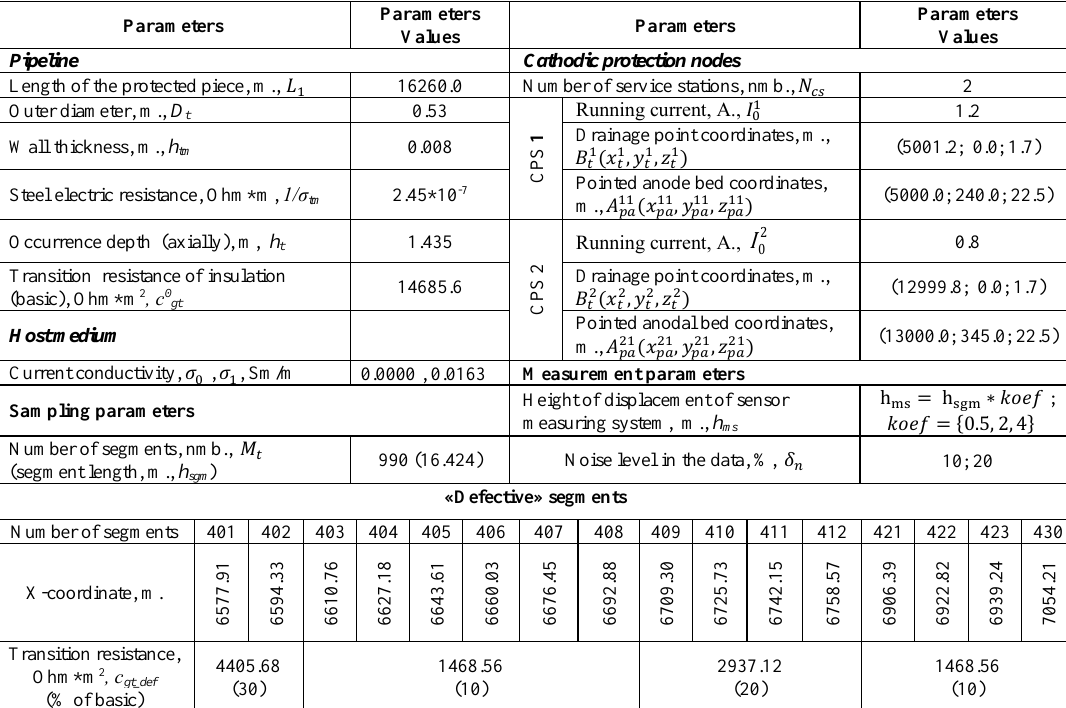
Table 1. Parameters used in the experimental